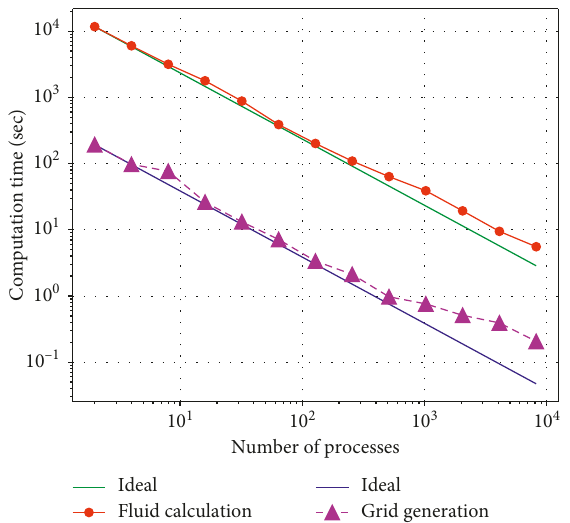
Figure 10: Performance of grid generation and fluid calculation for Flat-MPI mode.